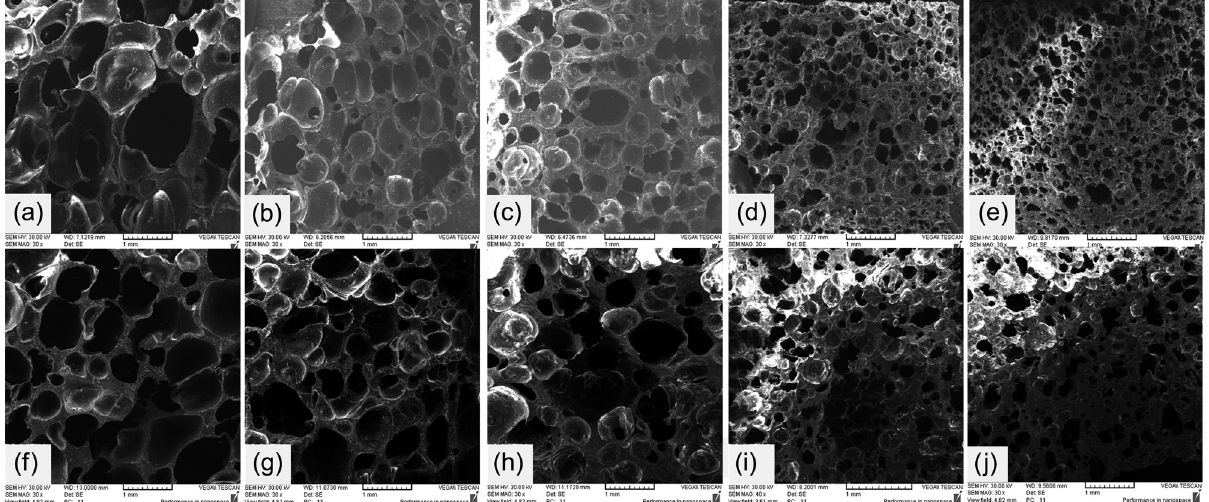
Figure 4: SEM images of NR foams prepared at 140°C ( a ) S0, ( b ) S10, ( c ) S20, ( d ) S30, and ( e ) S40 and prepared at 90 – 140°C ( f ) S0, ( g ) S10, ( h ) S20, ( i ) S30, and ( j ) S40 ( scale bar: 1 mm )